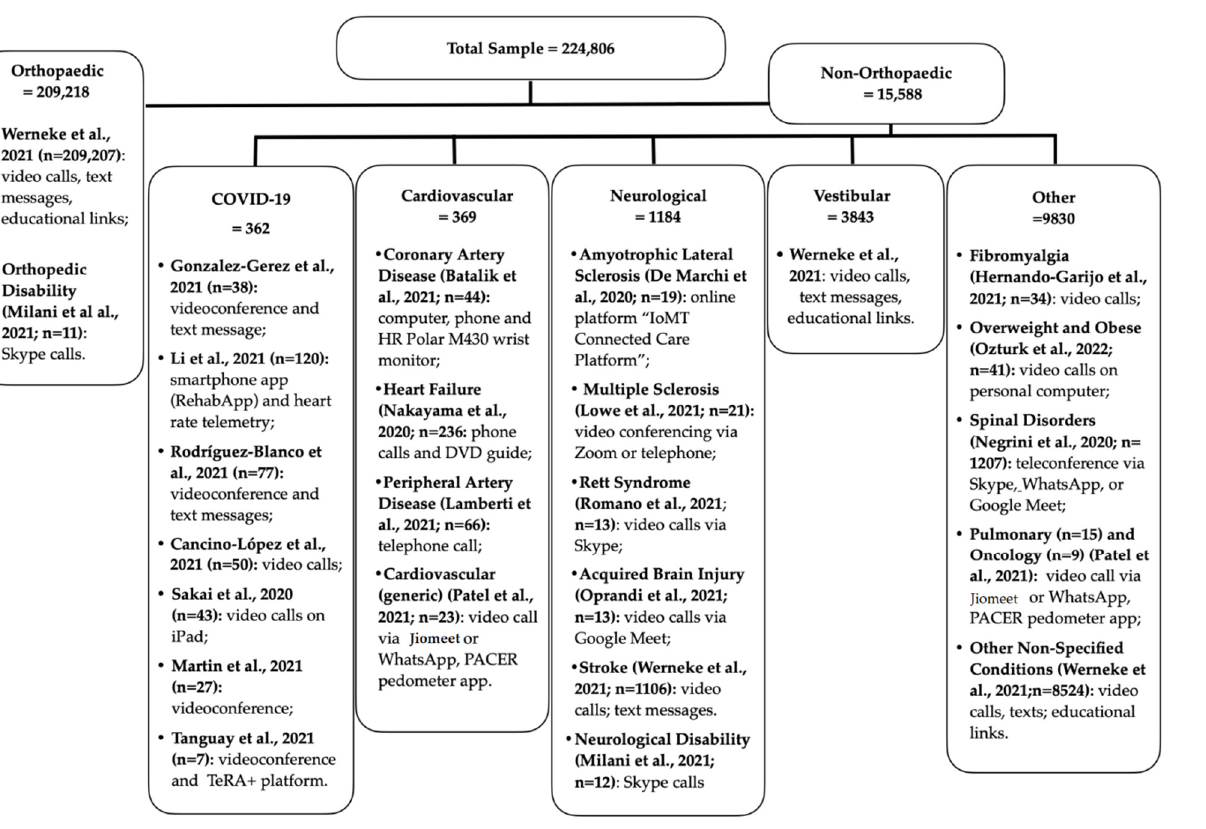
Figure 3. Schematic illustration of the total sample of the participants and the technologies used, divided by condition and study [22–41].